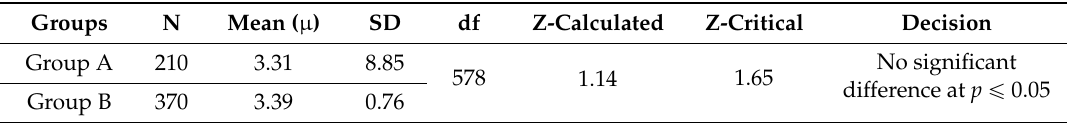
Table 3. Test of the significant difference in the mean students’ perceived thermal discomfort scores in LTH ‐ 2 and LTH ‐ 3.